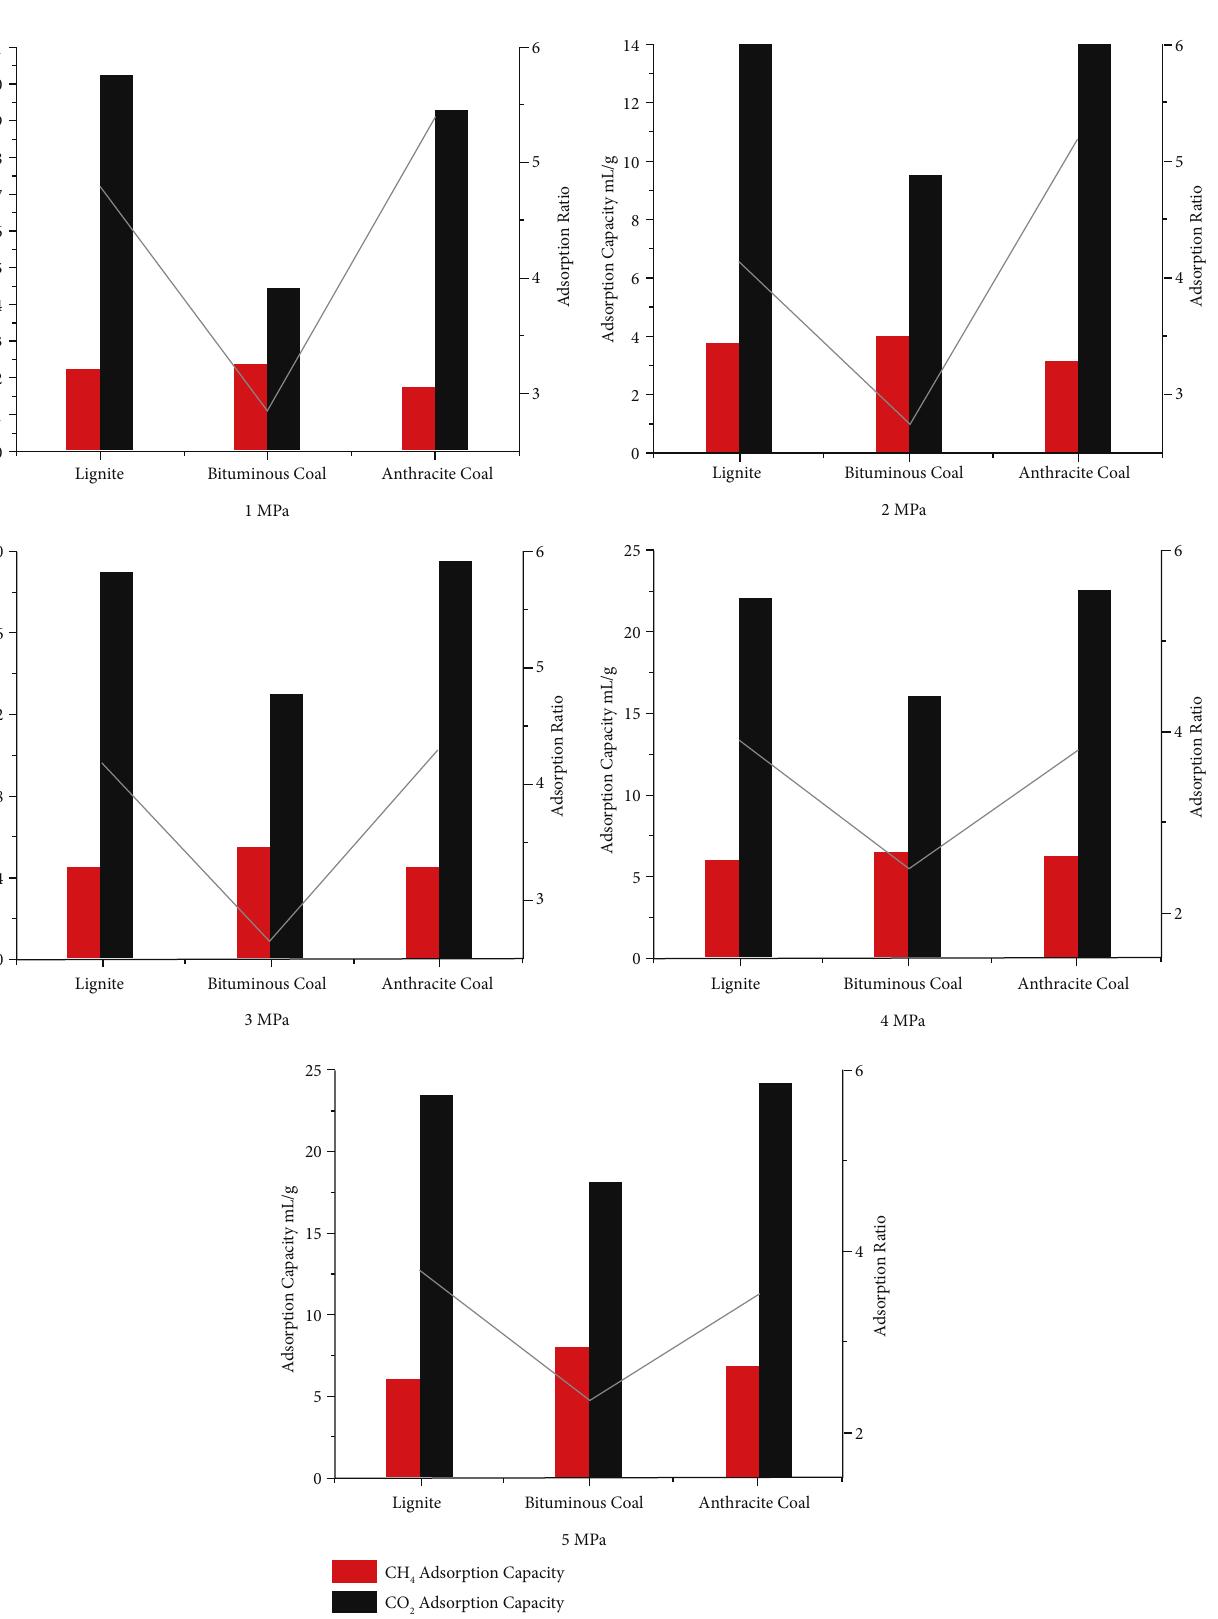
Figure 5: CO and CH adsorption capacity of di ff erent rank coal 2 4